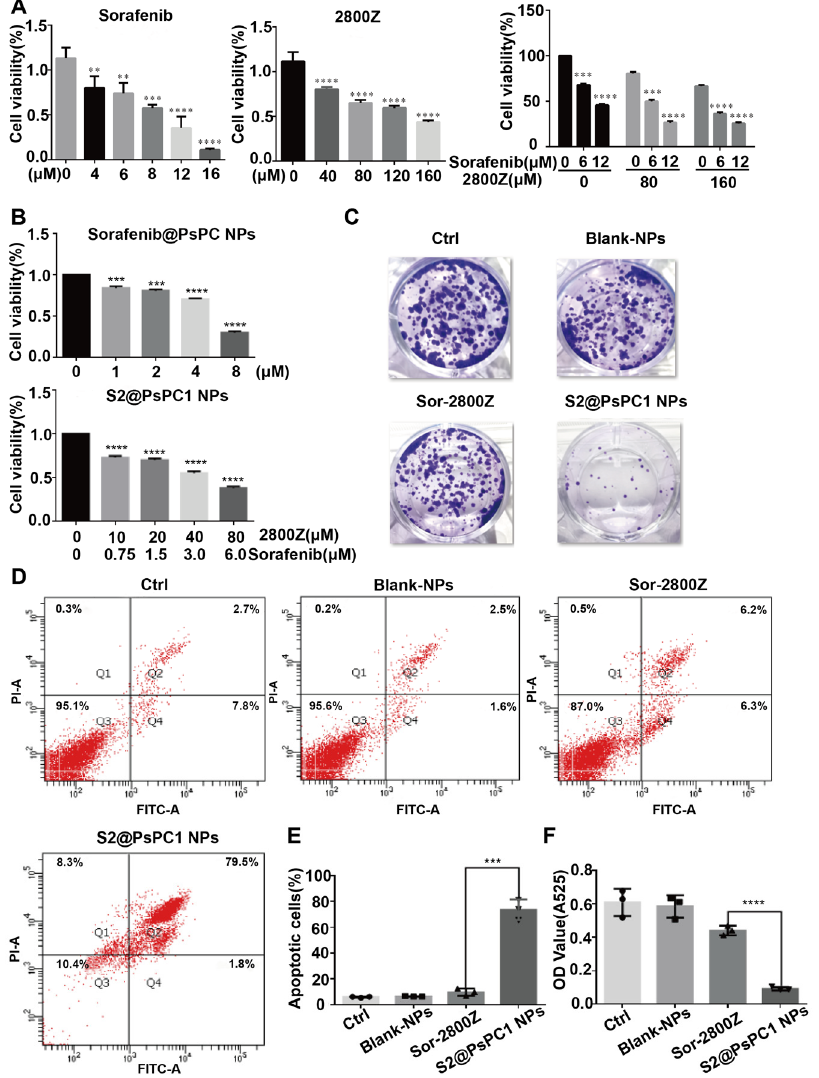
Figure 5. The S2@PsPC1 NPs inhibit cell proliferation, colony-forming activity, and promote cell apoptosis of Huh7.5-luc cells. ( A ) Huh7.5-luc cells were treated with a range of concentrations of sorafenib, 2800Z, or a combination, and cell viability was assessed 24 h after treatment using the CCK8 assay. ( B ) The viability of Huh7.5-luc cells was assessed at 24 h post Sorafenib@mPssPCs NPs or S2@PsPCs NPs treatment. ( C ) Huh7.5-luc cells was untreated or treated with free drug combinations of sorafenib and S2@mPssPC1 NPs for 10 days, with data being quantified in ( F ). ( D ) Representative flow cytometry analysis of cells stained with propidium iodide ( y -axis) and annexin V-FITC ( x -axis), with data being quantified in ( E ). Graphs show mean ± SEM of at least three independent experiments (** p < 0.01, *** p < 0.001, **** p < 0.0001, n = 3).